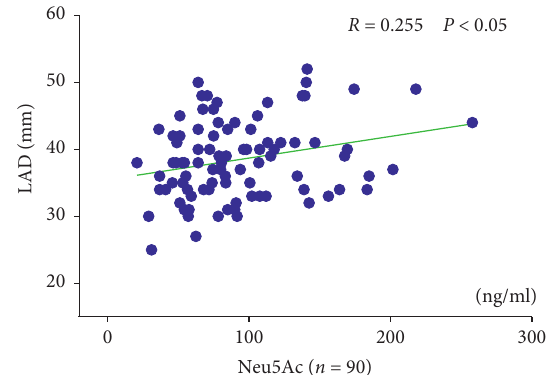
Figure 2: Correlation of plasma Neu5Ac levels with LAD. Neu5Ac: N-acetylneuraminic acid and LAD: left atrial diameter. R is Pearson’s correlation coefficient.